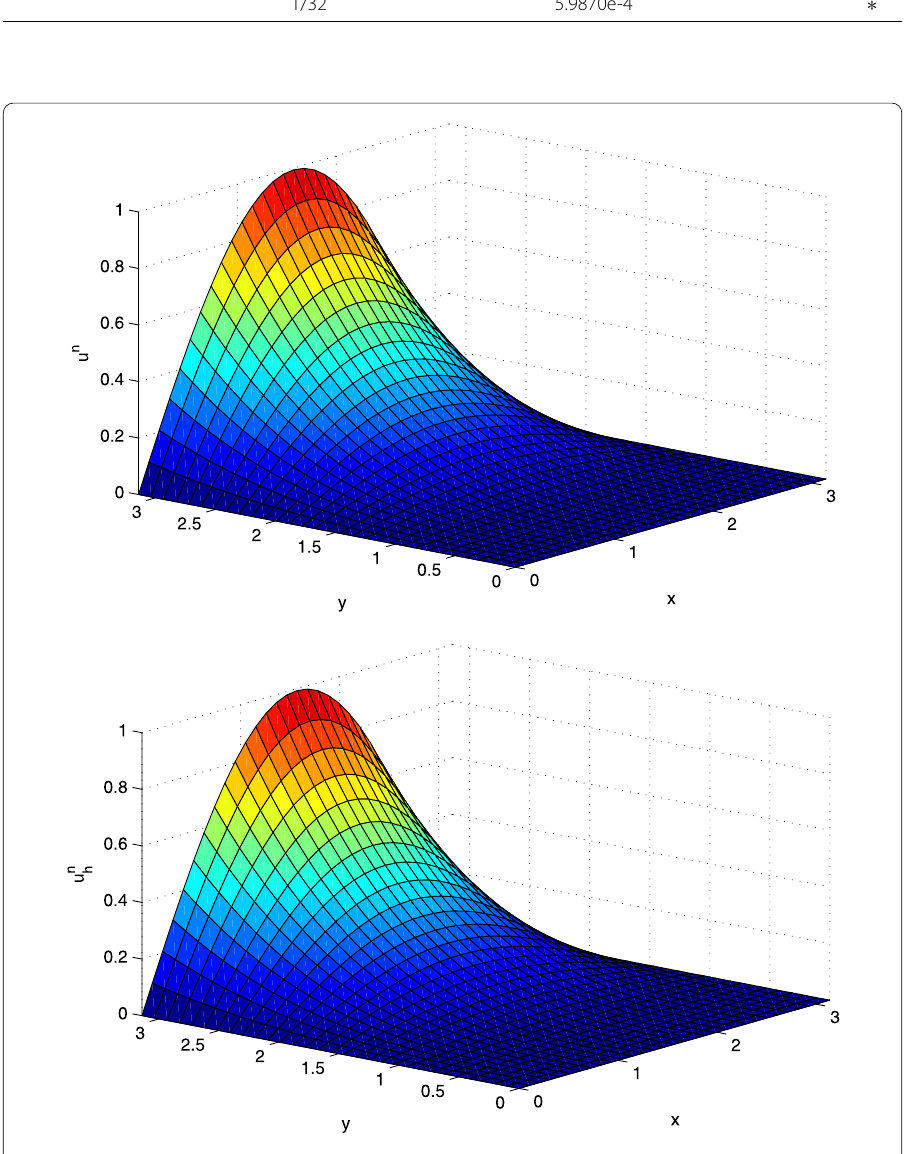
Figure 2 The exact solution (top) and numerical solution (bottom) for Example 2, when h = 0.05, τ = 0.05, β = 2 and T =